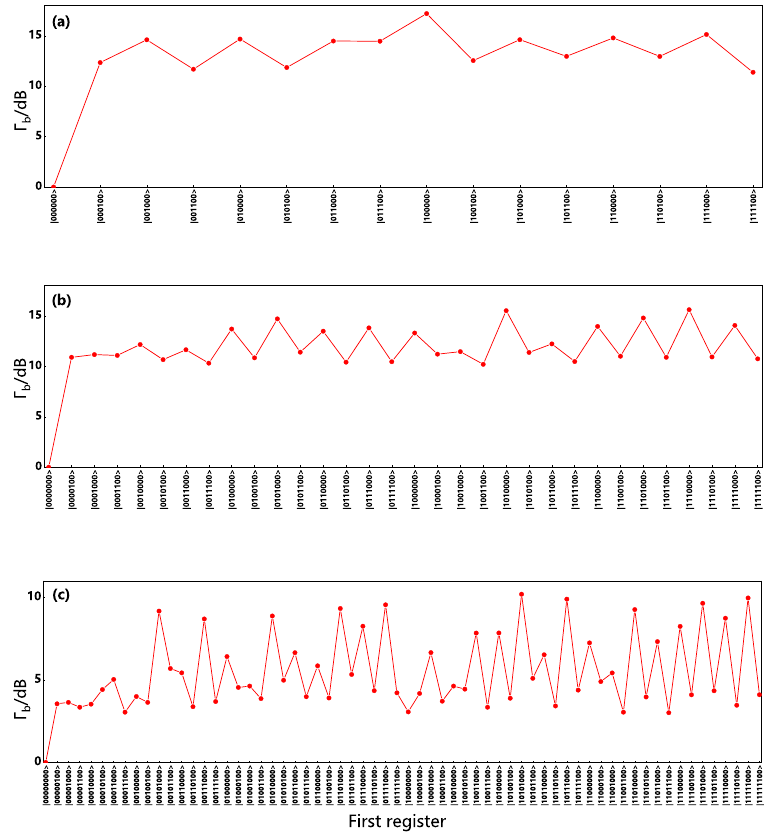
Figure A4. Calculation of Γ b for k = 6,7, 8 qubits. ( a ) The input state is | 0 (cid:105) ⊗ 6 . ( b ) The input state is | 0 (cid:105) ⊗ 7 . ( c ) The input state is | 0 (cid:105) ⊗ 8